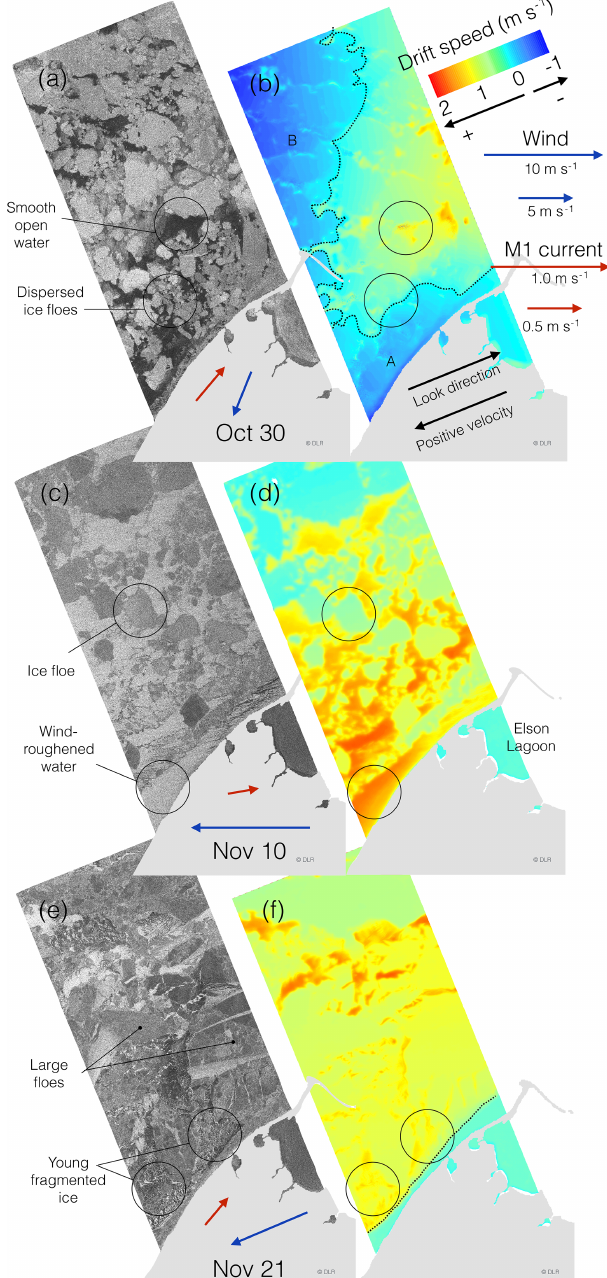
Figure 2. Three TanDEM-X backscatter images individually stretched to emphasize different ice types and features (a, c, e) and phase-derived speed in the look direction (b, d, f) by Utqia ˙ gvik dur- ing fall 2015 at 03:19UTC. Positive velocity is defined opposite of look direction. Line of zero velocity is marked with a dotted line. Velocity of wind (recorded in Utqia˙gvik) and currents (at M1) at the time of acquisition are indicated with blue and red arrows respec- tively. Land is masked out in light gray. “A” and “B” indicate areas of negative velocity in (a) further discussed in the